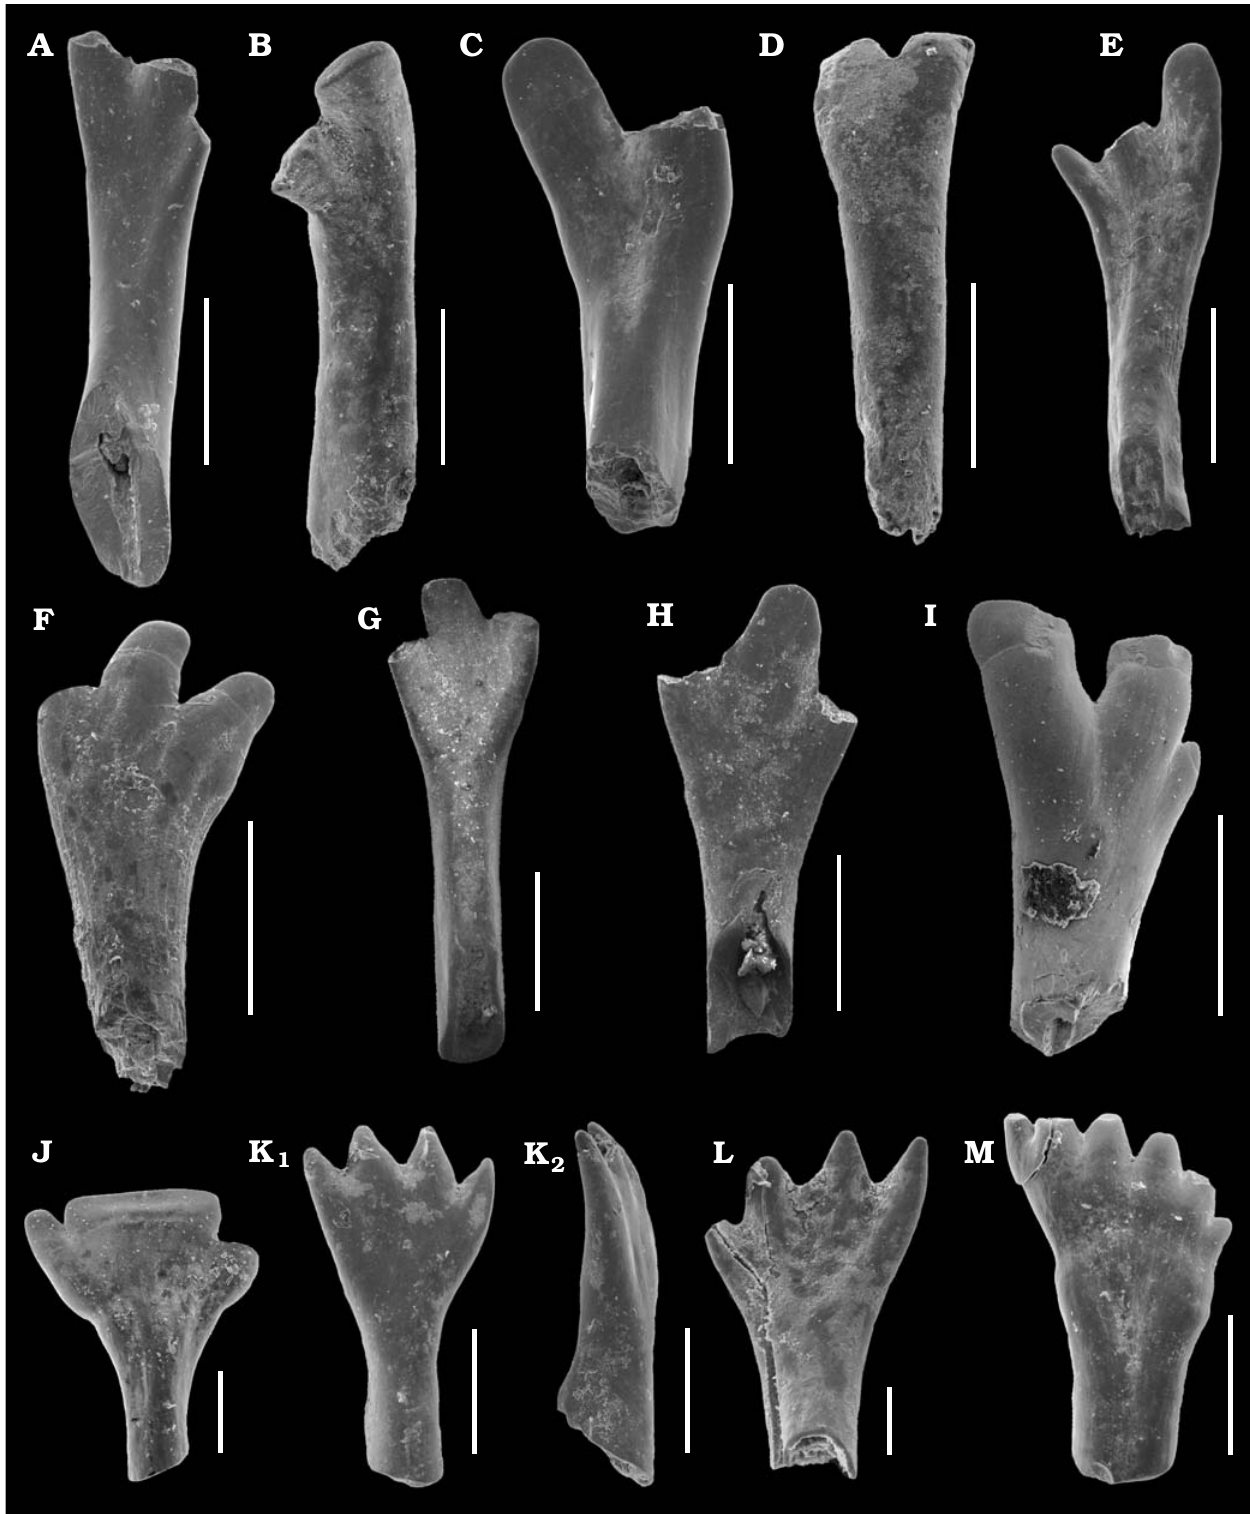
Fig. 2. The isolated teeth of actinopterygian fish Isadia from the Sokovka outcrop, Vyazniki, Russia, late Permian (Upper Vyatkian). A – D . Isadia aristovi- ensis Minikh, 1990, mandibulary teeth. A . ZPAL V.51/1, lingual view. B . ZPAL V.51/2, labial view. C . ZPAL V.51/3, lingual view. D . ZPAL V.51/4, labial view. E – I . Isadia aristoviensis Minikh, 1990, maxillary teeth. E . ZPAL V.51/6, lingual view. F . ZPAL V.51/7, labial view. G . ZPAL V.51/5, lingual view. H . ZPAL V.51/8, lingual view. I . ZPAL V.51/9, labial view. J . Isadia arefievi Minikh, 2015, ZPAL V.51/10, mandibular tooth, ?lingual view. K , L .